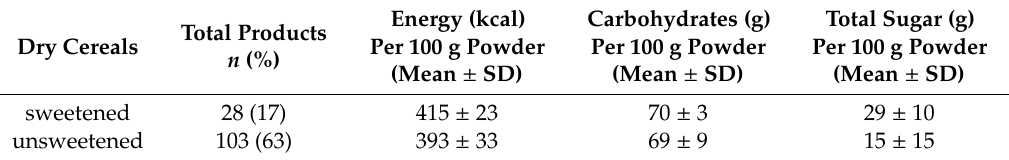
Table 3. Mean energy, as well as carbohydrate and sugar contents of sweetened and unsweetened dry cereals as reported on food labels.